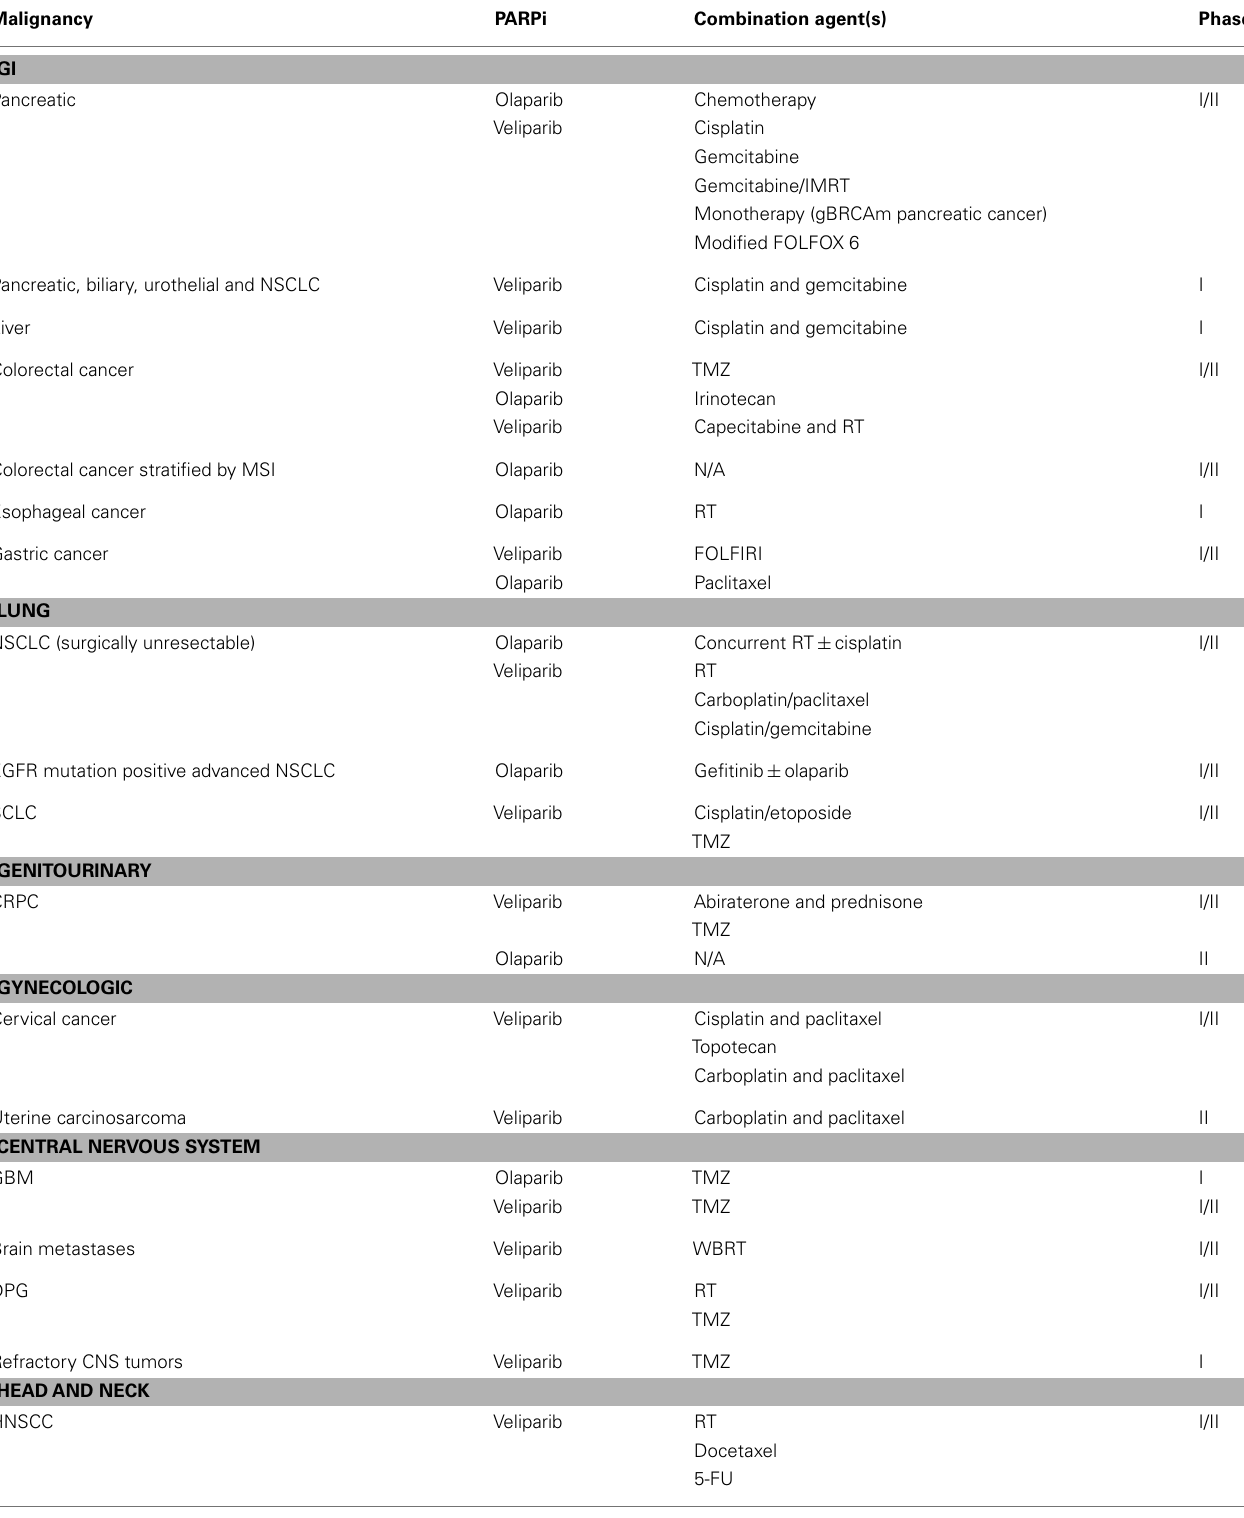
Table 2 |Trials of PARPi in solid tumors (excluding breast and ovarian